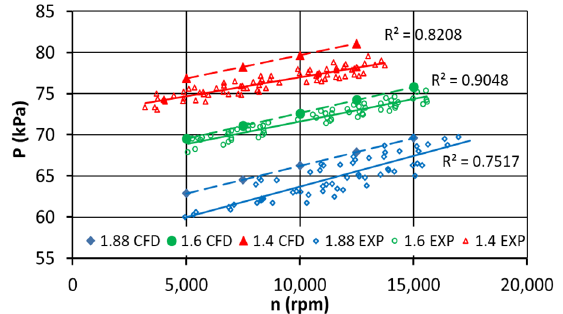
Figure 11. Pressure in the tip clearance as a function of rotational speed for different pressure ratios.